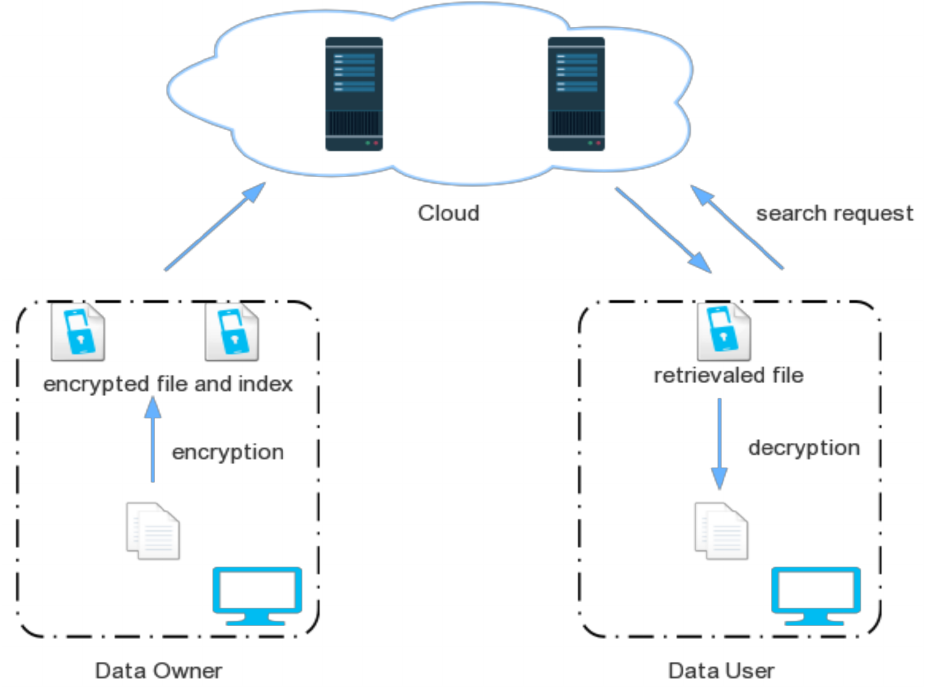
Figure 3. Encrypted search in Cloud storage. Reproduced from